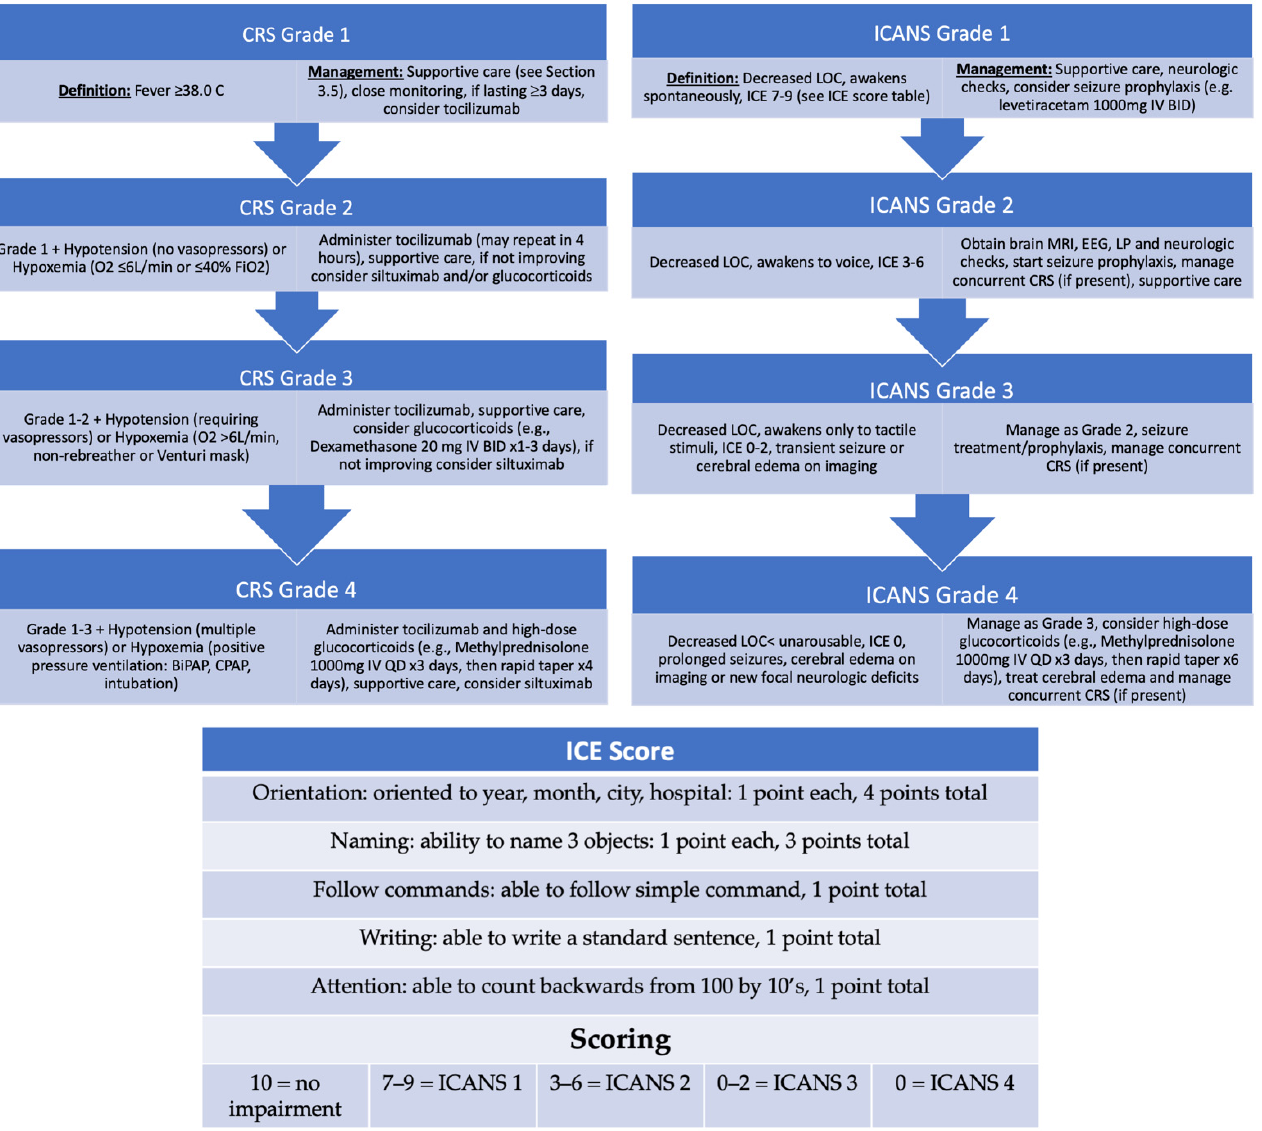
Figure 3. General guidance regarding management of CRS and ICANS, including ICE scoring table.